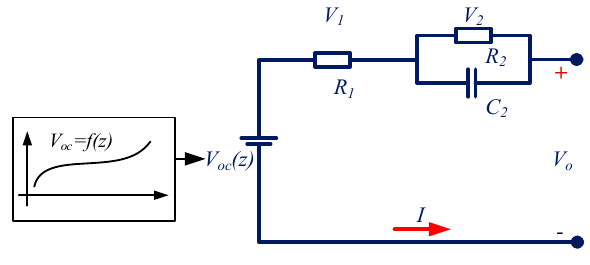
Figure 1. The simplified battery model.